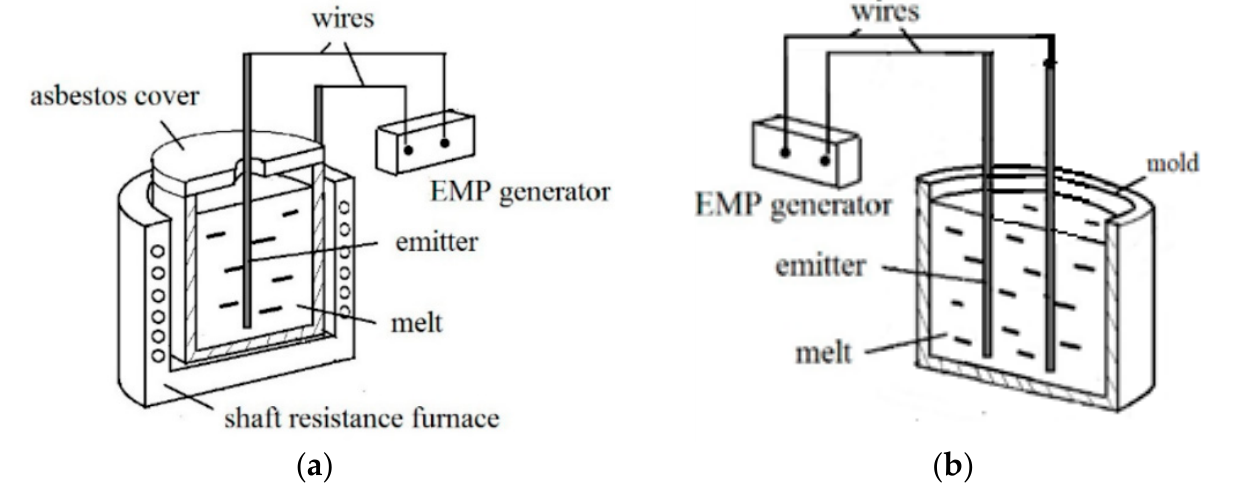
Figure 5. Schemes of processing melts: ( a ) in the furnace [18]; and ( b ) in a mold [10].